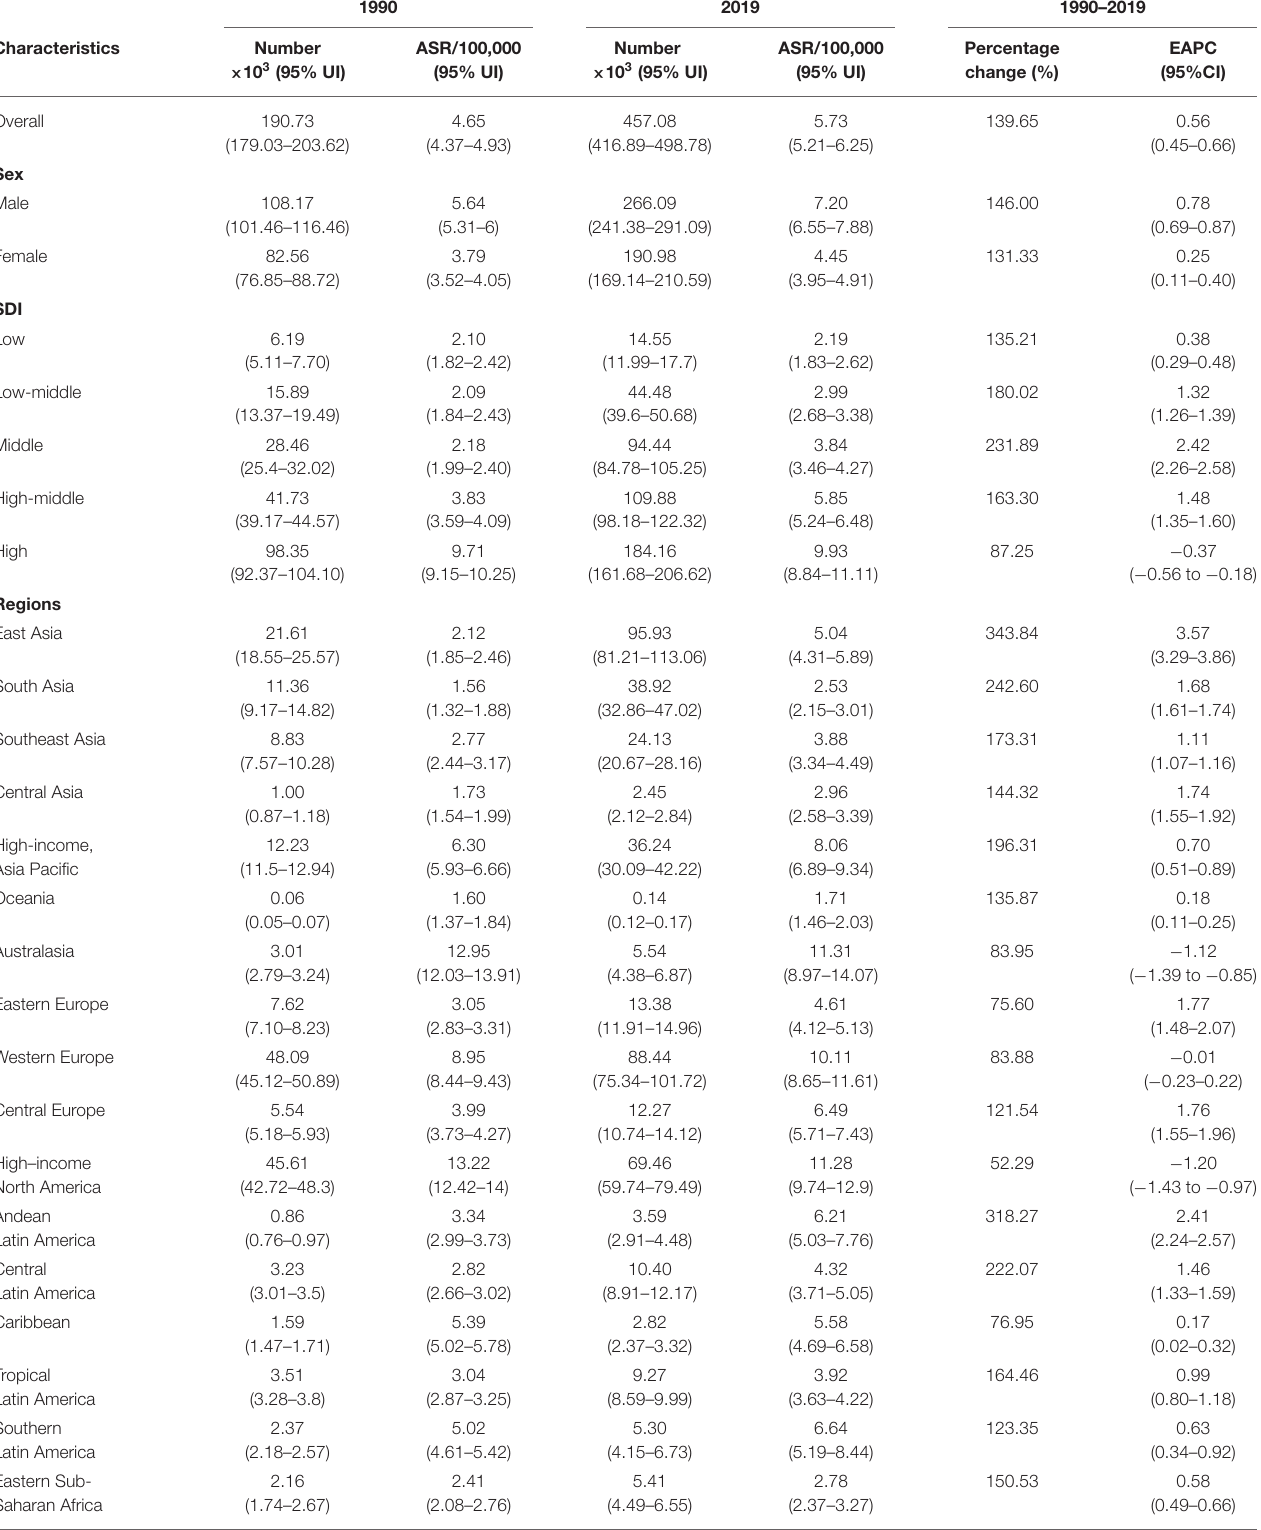
TABLE 1 | Number and age-standardized rate of non-Hodgkin lymphoma incidence on a global scale by sex, SDI areas, and geographic regions in 1990 and 2019, and the percentage change of absolute number and the EAPCs from 1990 to